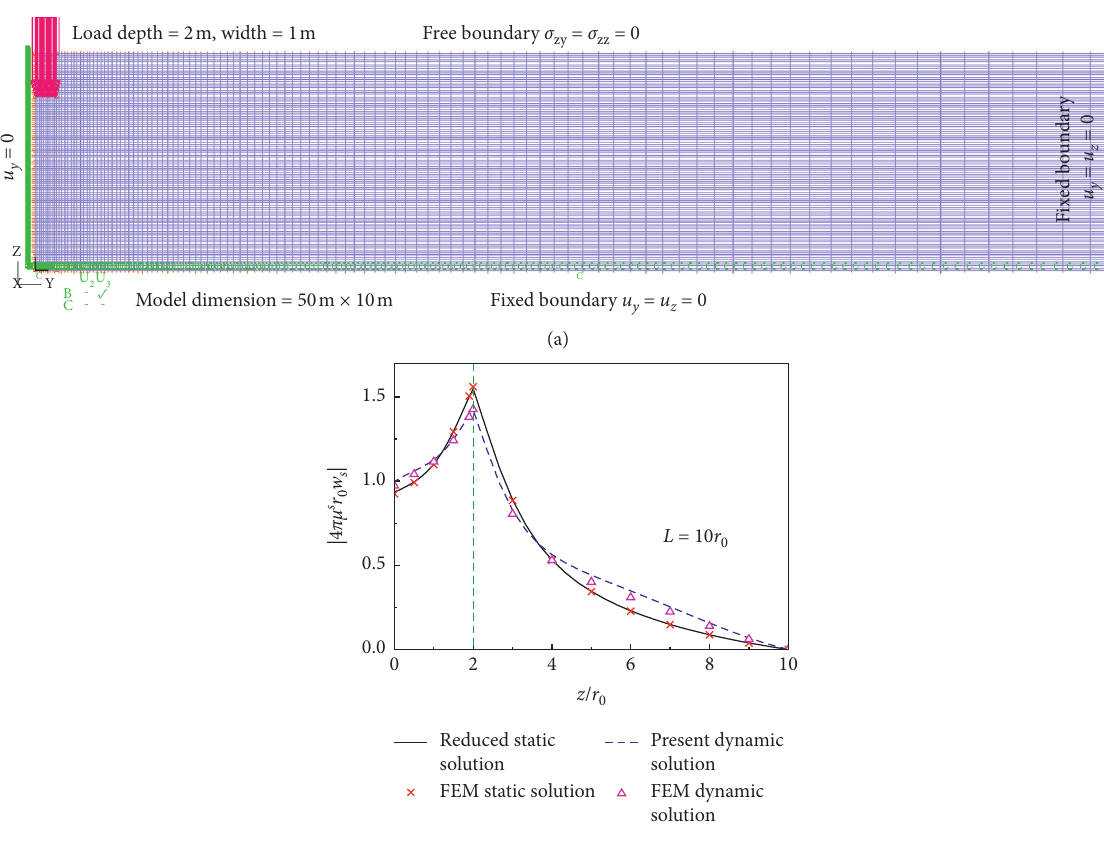
s induced by unit vertical load on π s : (a) real part of vertical displacement; (b) imaginary part of vertical